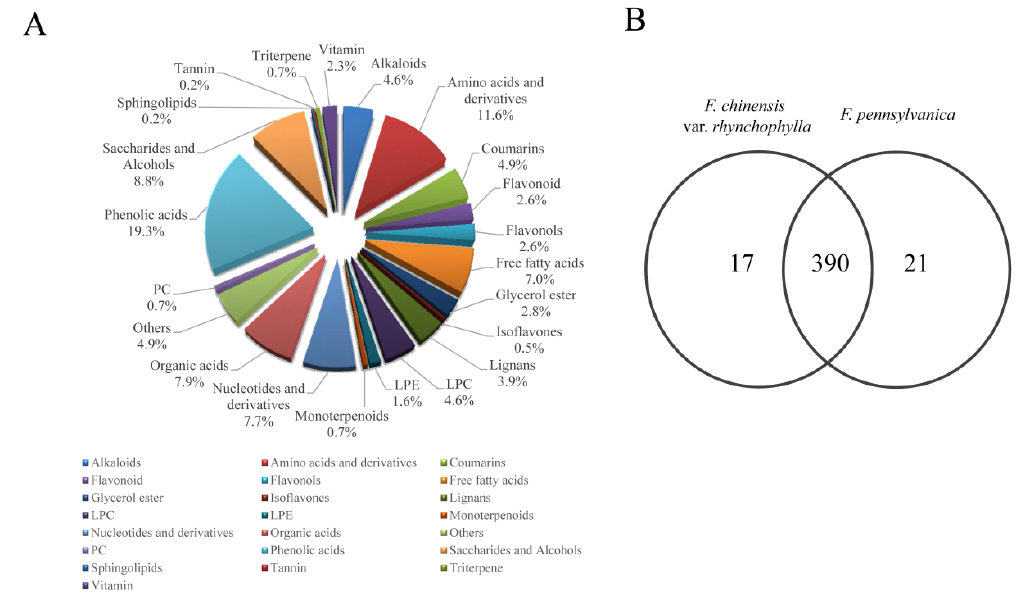
Figure 1. Types and Venn diagram of metabolites detected in F. chinensis var. rhynchophylla and F. pennsylvanica . ( A ) Types and percentages of metabolites detected in the two species. ( B ) Venn diagram showing the overlapping and unique differential metabolites between F. chinensis var. rhynchophylla and F. pennsylvanica .